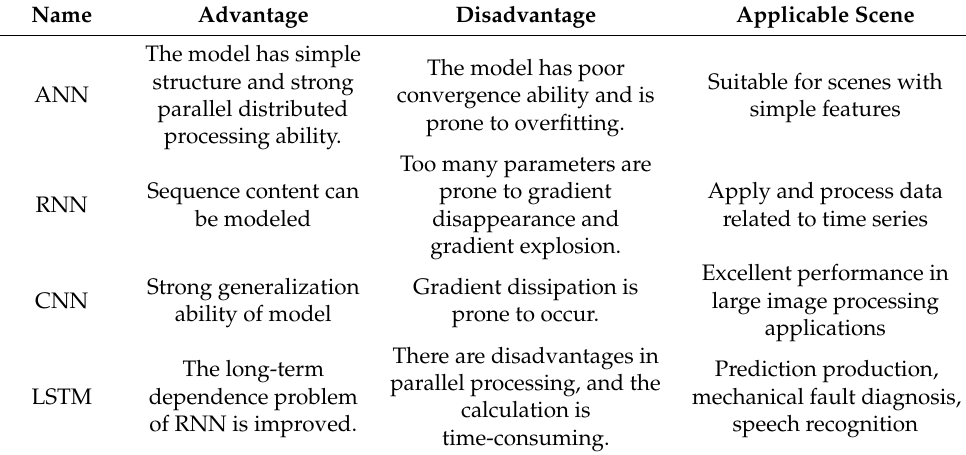
Table 1. Mainstream neural network model structure